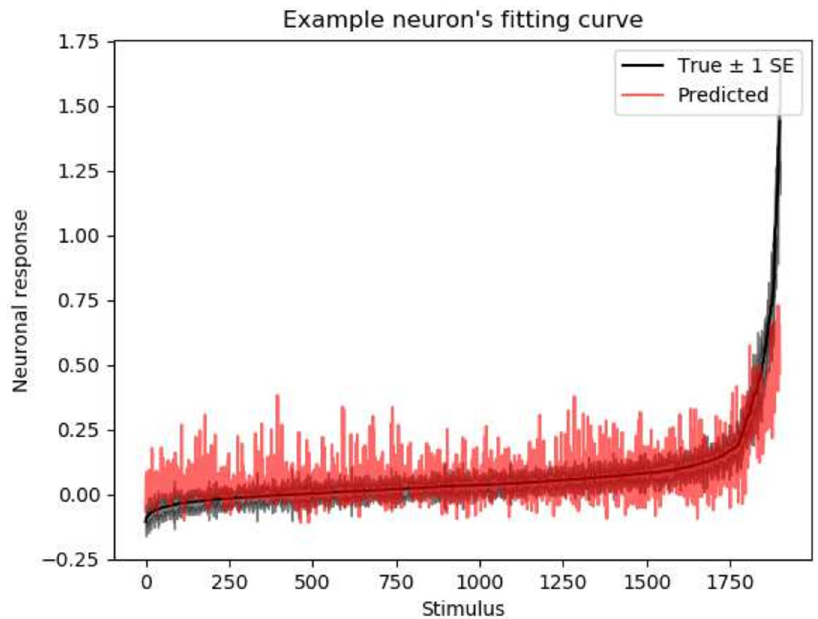
Fig 5. Predicted tuning curve versus actual tuning curve. An example of a real neuronal tuning curve to the 1900 stimuli from the testing dataset (not used during training), ordered by the response magnitude (black curve, with ± 1 standard error estimated from the trial-by-trial variance). The red curve shows the model’s predicted response to these stimuli. The Pearson correlation (0.61 in this example) between these two curves is calculated as a quantitative evaluation